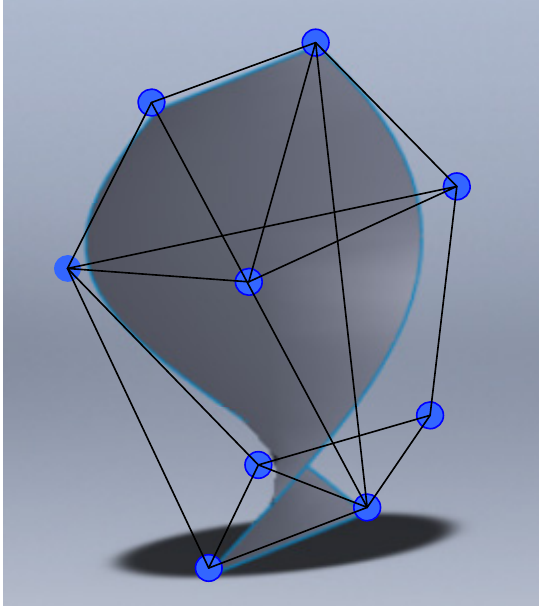
Figure 5. Bezier surface. Therefore, each control point can be thought of as a vector. (3) Projection conversion In view transformation, the object is transformed into observation coordinates and is